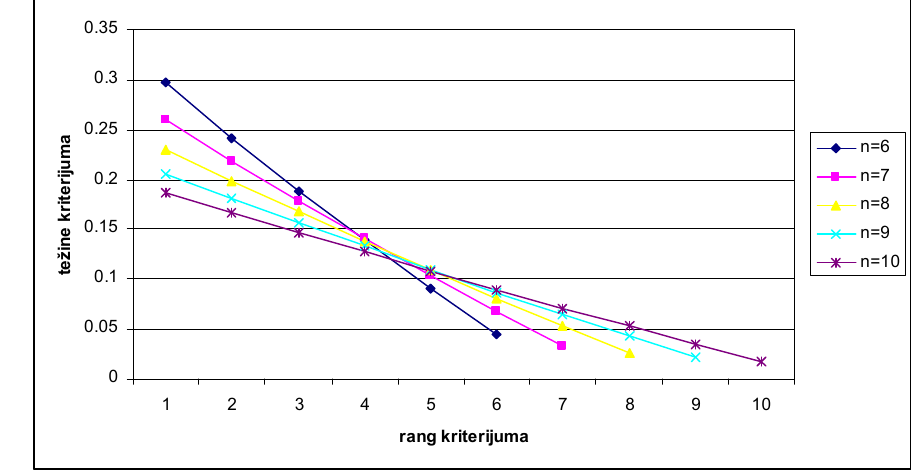
Figure 5 – Graph of the weight values for n={6,7,8,9,10} of the criteria obtained by the ROD Metoda geometrijskih težina (MGT) predložena je u (Lootsma,